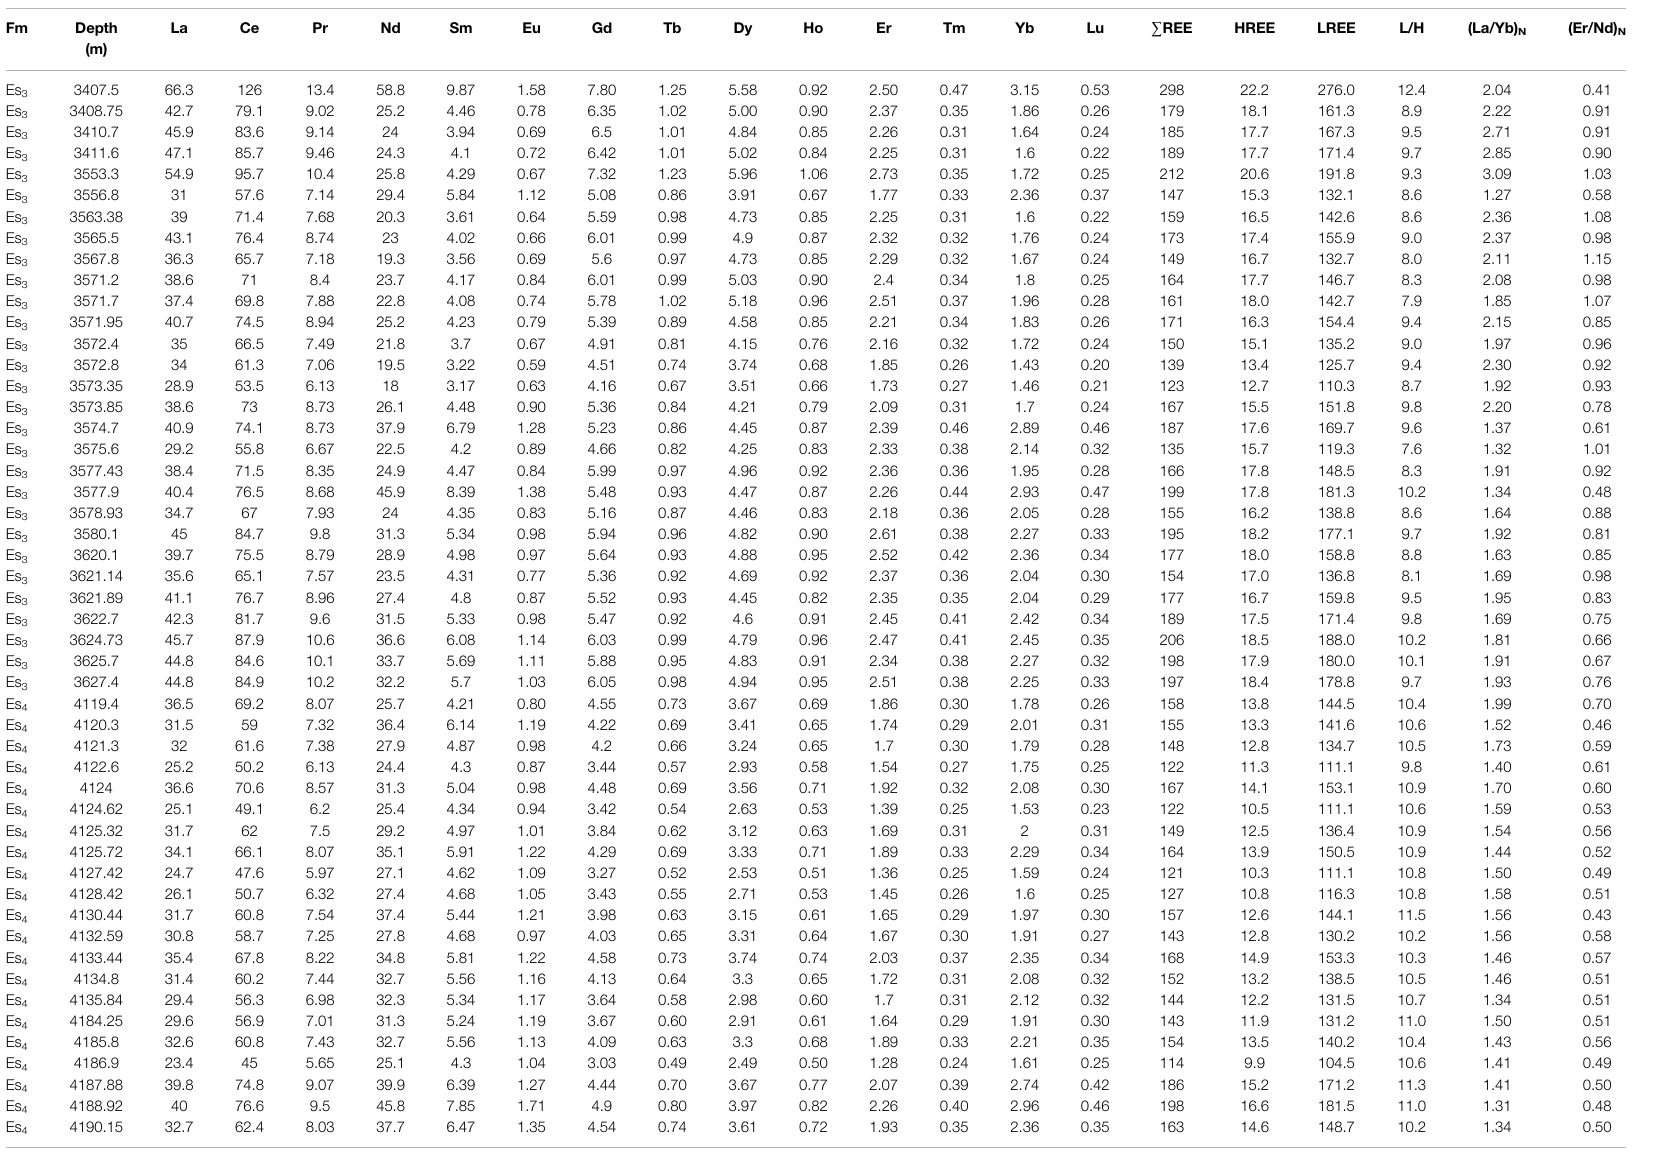
TABLE 3 | Rare earth element concentrations ( μ g/g) and corresponding calculated parameters of Es 3 and Es 4 mudstone in the Langgu sag. Fm Depth